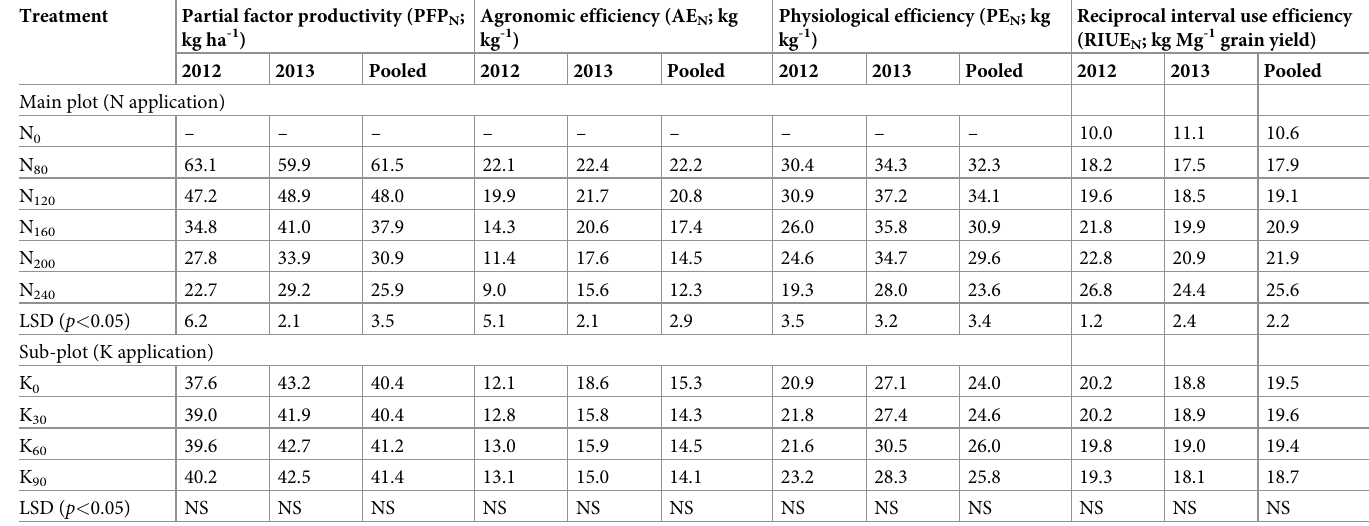
Table 5. Effect of nitrogen (N) and potassium (K) application on N use efficiency in wheat ( Triticum aestivum L.) in a sandy loam soil in sub-tropical India. Treatment Partial factor productivity (PFP N ; kg ha -1 )